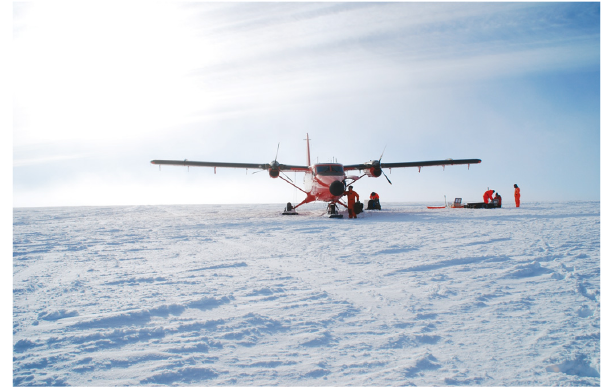
Fig. 3. Picture of the Plateau Laclavere (63 ◦ 27 0 10 00 S, 57 ◦ 45 0 32 00 W, 1030m a.s.l.) reached the first time on the 31 January 2010 with a Twin-Otter aircraft of the Chilean Air Force. From this location a firn core of 11m depth was extracted